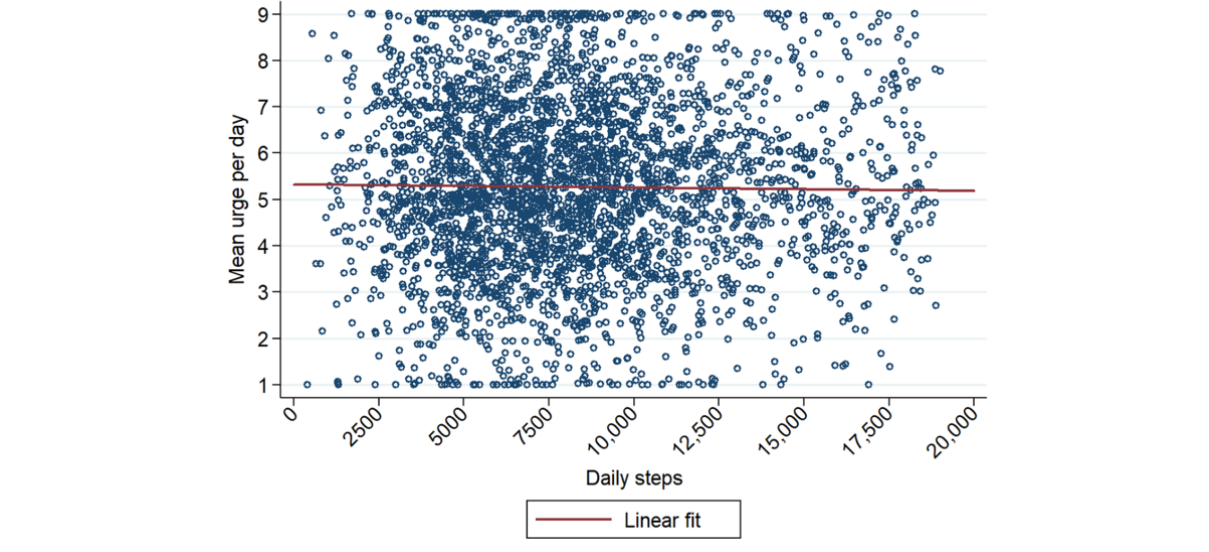
Figure 2. Mean urge per day plotted against daily steps, after applying exclusion criteria and omitting outliers.